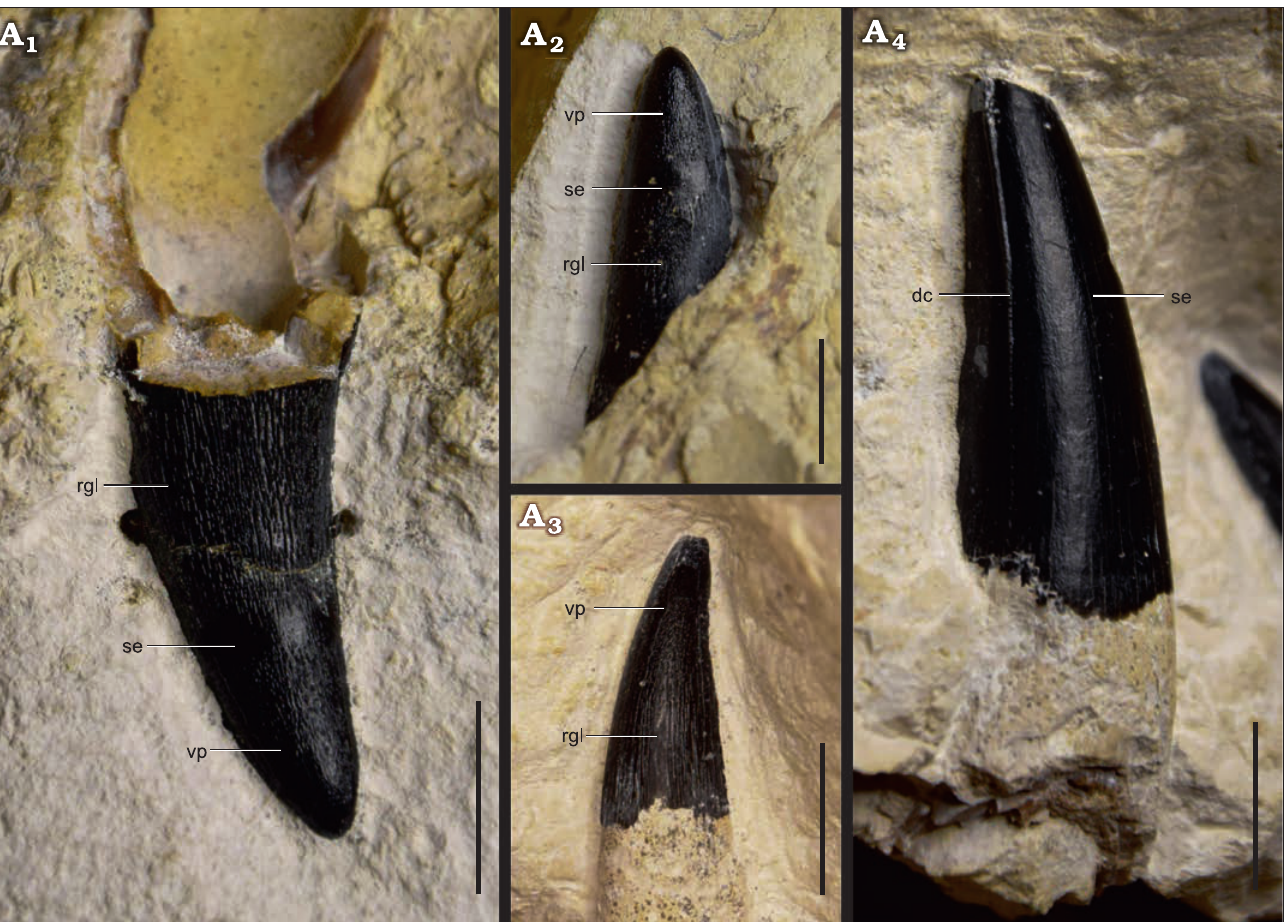
Fig. 8. Selected tooth crowns of an indeterminate metriorhynchid (MZ VIII Vr-72) from an unknown locality and age, showing observable features of the enamel: “premaxillary” teeth in lingual view (A 1 , A 2 ), “dentary” teeth (A 3 , A 4 ), showing the only tooth crown accessible from lingual side (A 3 ) and the smooth labial surface (A 4 ). Note the absence of the smooth enamel band at the mid-section (A 3 ). Abbreviations: dc, distal carina; rgl, ridglets; se, horizontal band of smooth enamel; vp, vermicular pattern. Scale bars 10